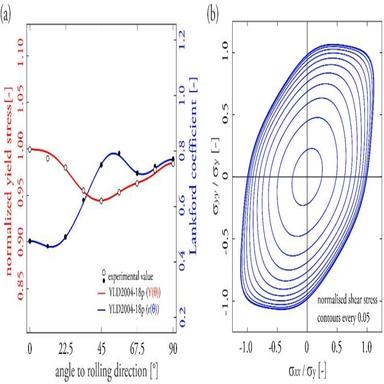
The result of the conventional calibration procedure (Step 1) of the αI parameters associated with the in-plane stress state of YLD2004–18p: (a) The predicted normalised yield stress (in red) and r-value (in blue) as a function of angle to the rolling direction. The measured values are shown with dots. (b) The identified shape of the yield surface.